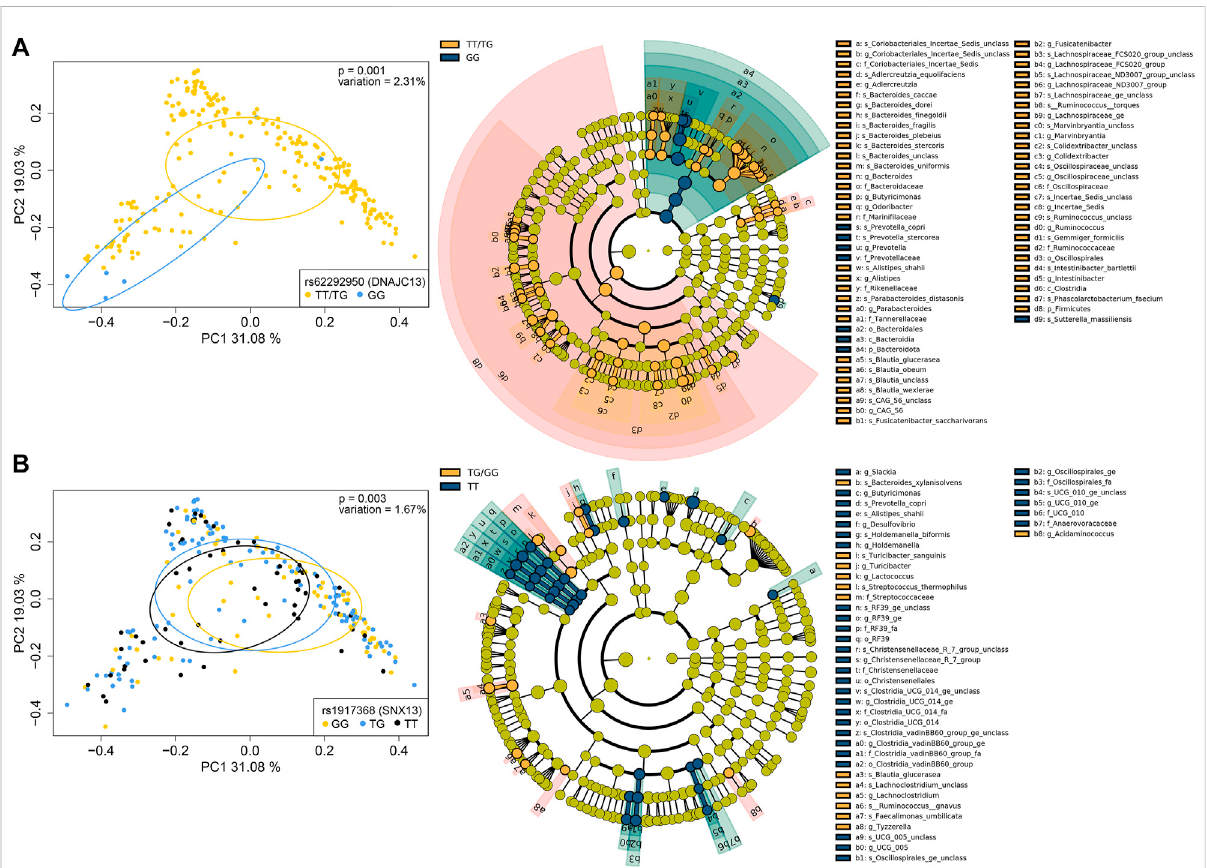
FIGURE 7 Genotype-associated gut microbiome changes. (A) PCoA plots of microbiome pro fi les, based on weighted UniFrac distances, with samples grouped by the TT/TG and GG genotypes for rs62292950 (DNAJC13) (left) and cladogram showing taxa with signi fi cantly different abundances between subjects with the TT/TG and GG genotypes, assessed by LEfSe (right). (B) PCoA plot of microbiome pro fi les with samples grouped by the GG, TG, and TT genotypes for rs1917368 (SNX13) (left) and cladogram showing taxa with signi fi cantly different abundances between subjects with the TG/GG and TT genotypes (right). Bacterial classi fi cations at the phylum (p_), class (c_), order (o_), family (f_), genus (g_), and species (s_) levels are